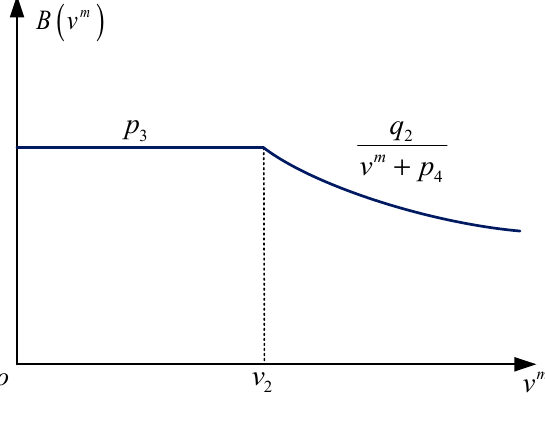
Figure 3. Braking characteristic curves.